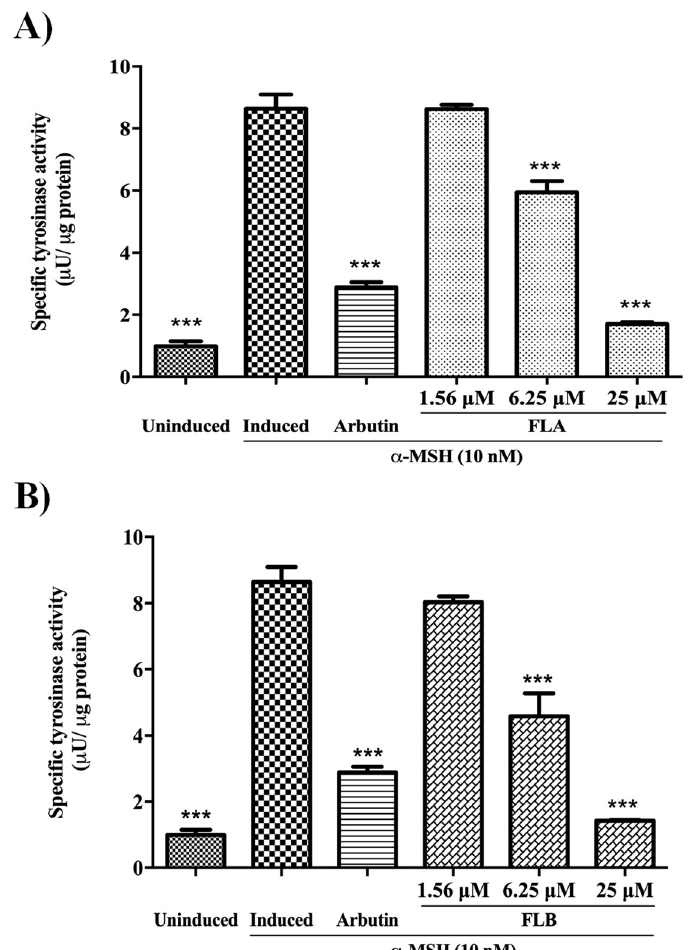
Figure 3. Effect of chalcone derivatives on cellular tyrosinase activity of α-MSH-induced B16/F10 cells. Cellular tyrosinase activity after treated with ( A ) FLA and ( B ) FLB. Both compounds were tested at different concentrations (25, 6.25 and 1.56 µM) and incubated for 72 h. Arbutin (50 µM) was used as positive control. All values are the mean ± S.E.M. of three independent experiments. A value of *** p < 0.001, was considered significantly different to α-MSH-induced control group.